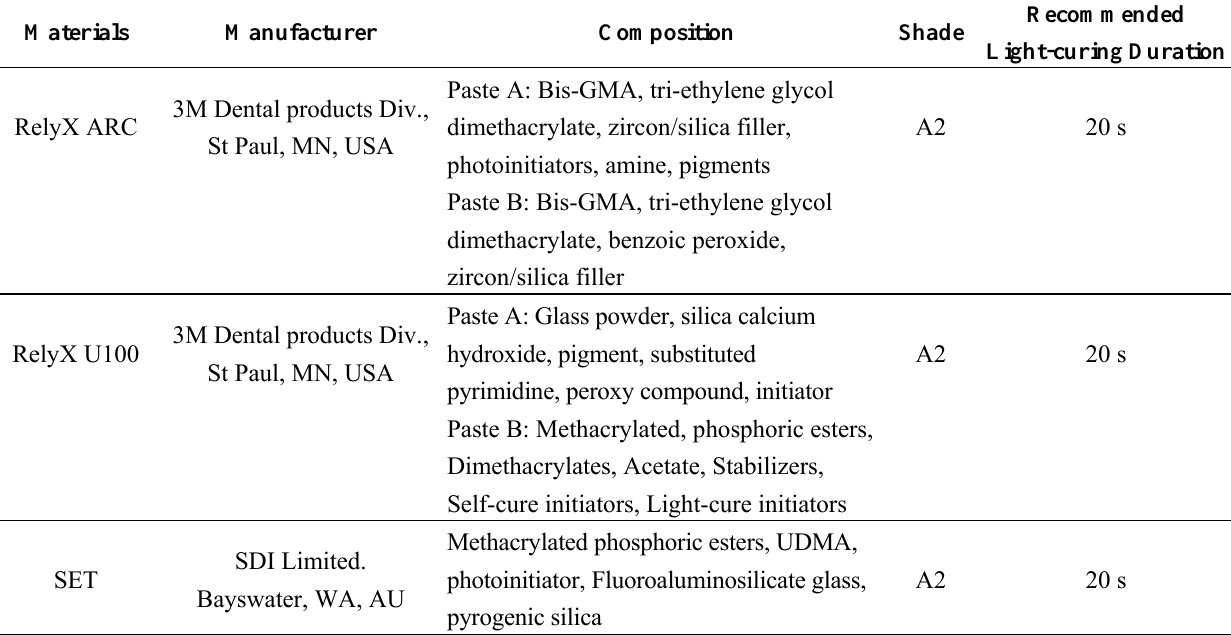
Table 2. Dental materials used in the study.